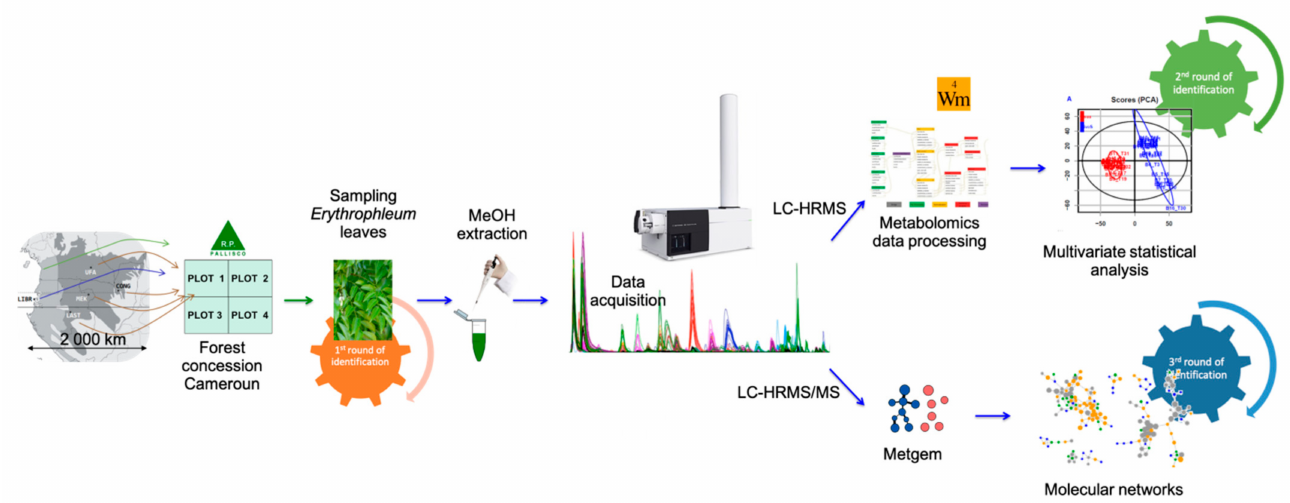
Figure 7. Experimental sampling design and overview of the workflow followed for metabolomics analysis of Erythrophleum leaves. E. suaveolens and E. ivorense from five populations were grown in 4 plots in a forest concession in Cameroon. Leaves of 44 trees were sampled, air-dried and metabolites were extracted with methanol (MeOH). Liquid chromatography coupled to electrospray ionization high-resolution mass spectrometry (LC–ESI-HRMS(/MS)) was performed to characterize the metabolome diversity. Data analysis was completed by exploration using molecular